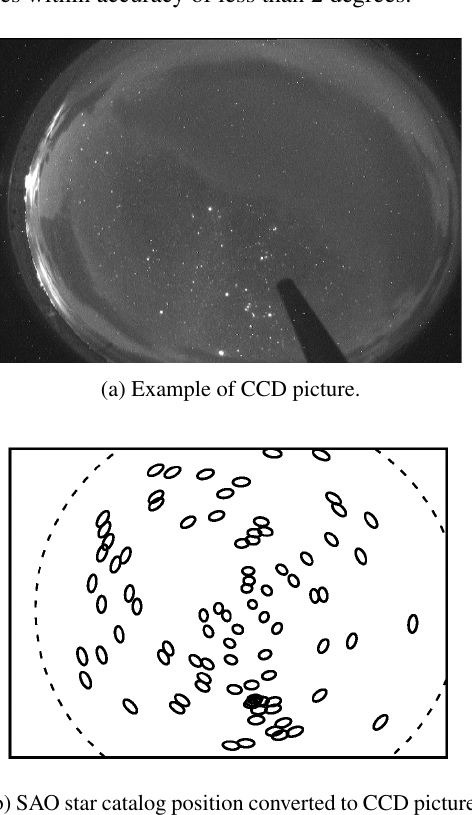
catalog position. Black dashed circle is field of view of CCD camera. Figure 6: Example of converted SAO star catalog